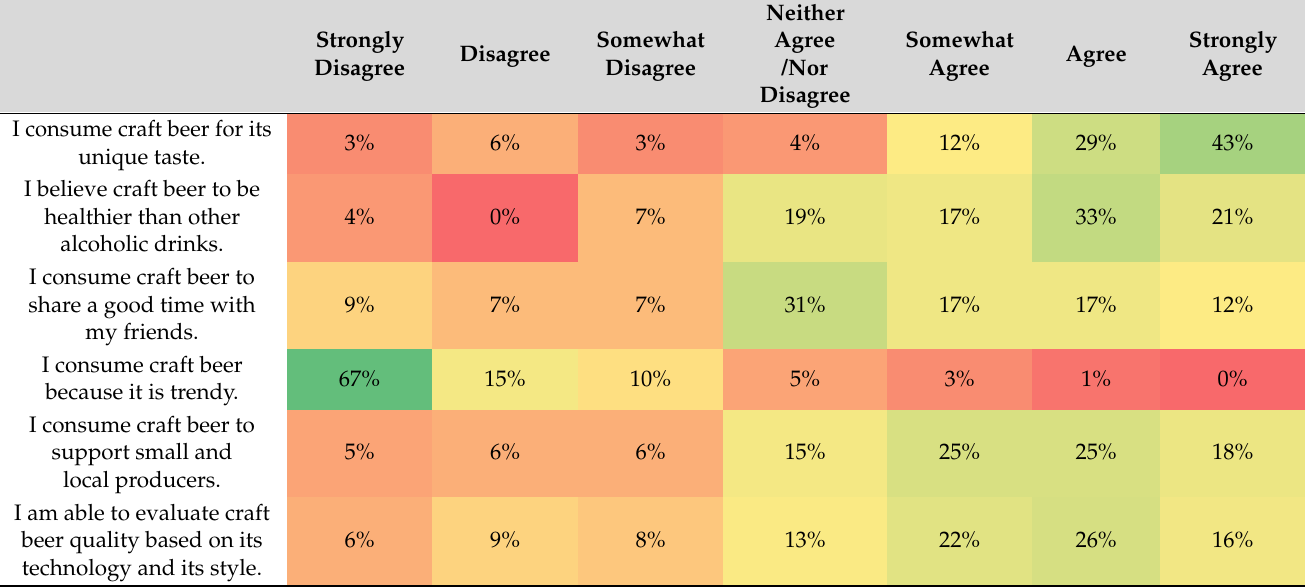
Table 4. Consumer motivations.